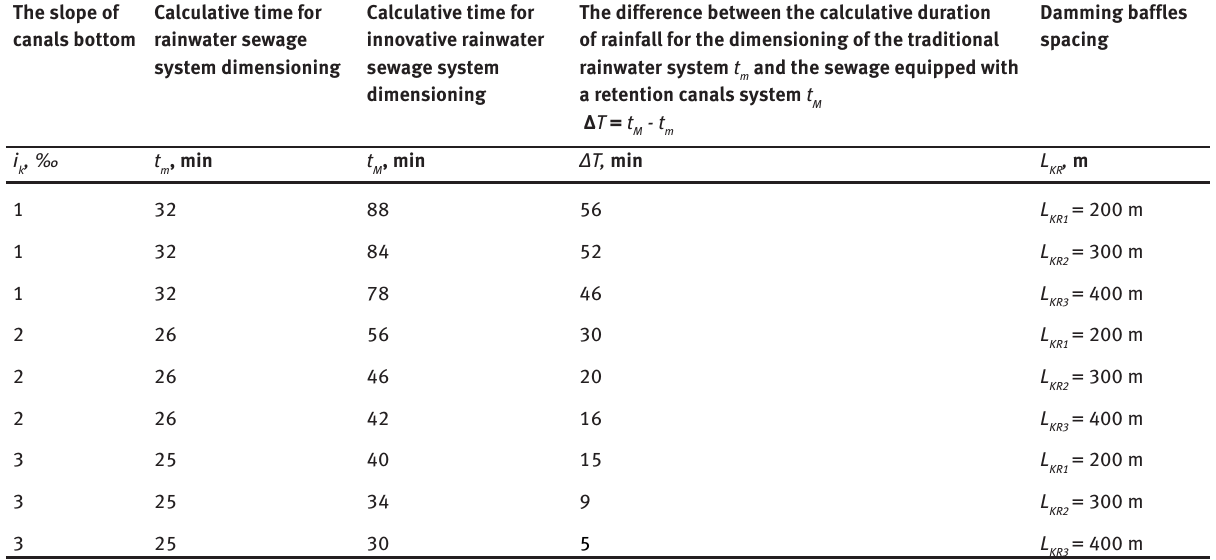
and t for different variants of sewer system working. m M